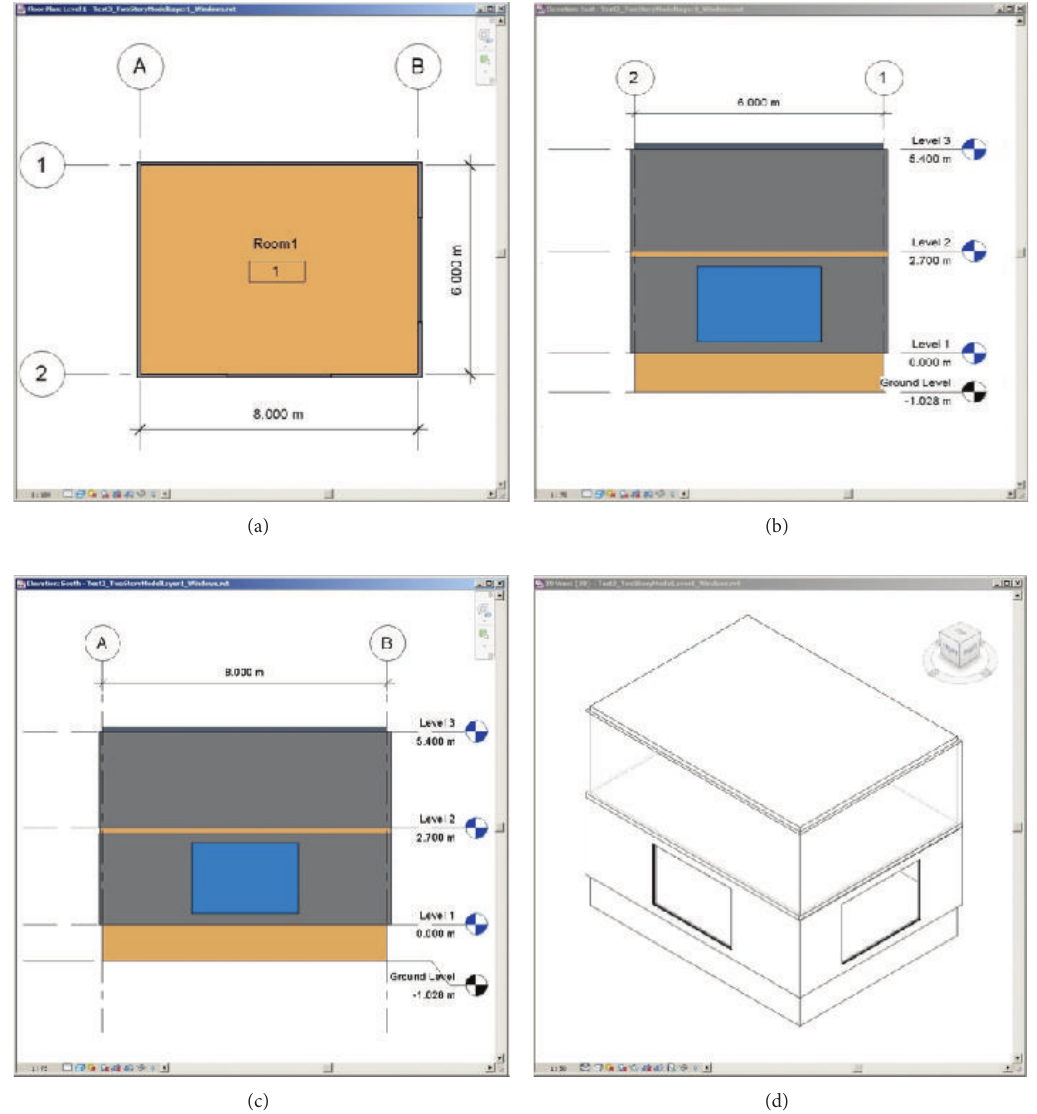
Figure 11: A two-story Revit model. (a) Floor-plan view of first level, (b) East-elevation view, (c) South-elevation view, and (d) isometric view.